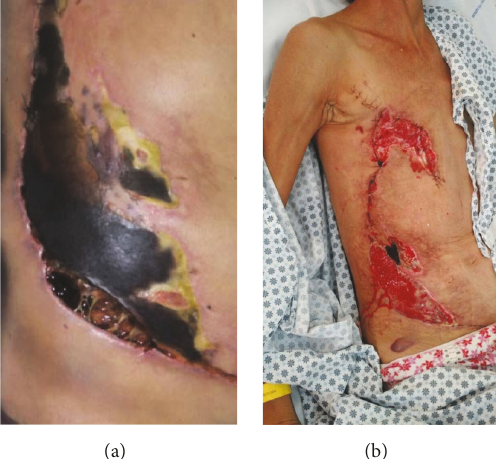
Figure 4: Necrosis of the surgical flap (a) and final aspect after debridement (b).